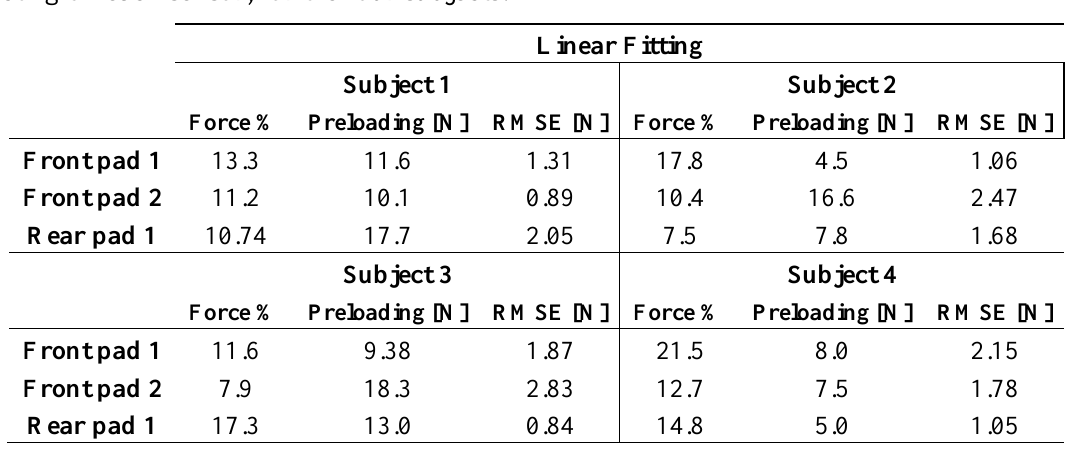
Table 3. Fraction of the interaction force unloaded on each pad, and preloading force acting on each sensor, for the four